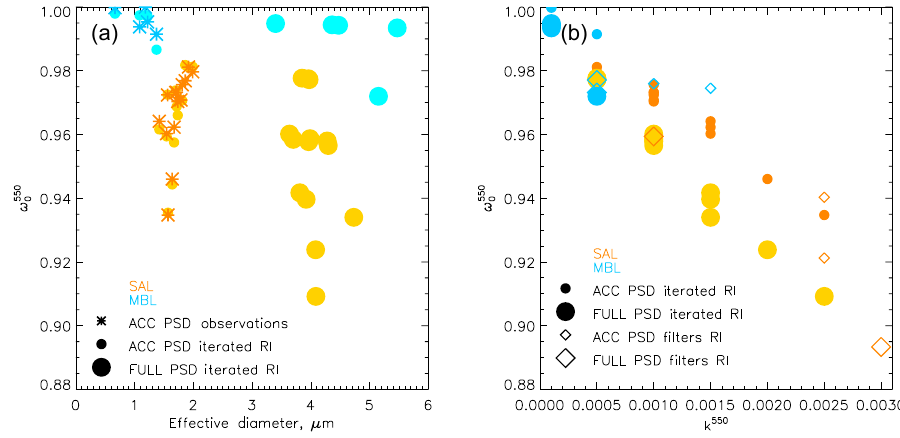
Figure 13. Contribution to single scattering albedo from particle size ( a SSA vs. d eff ) and from composition ( b SSA vs. k 550 ), separated by SLRs in the SAL (orange and yellow) and MBL (blue). Small data points represent the ACC PSD only; large data points represent the FULL PSD. Asterisks in (a) are direct observations behind inlets. Circles represent calculations using the RI derived from Mie iterations; diamonds represent calculations using RI derived from composition data from filter samples assuming internal mixing (four samples). For the FULL PSD with the iterated RI, the same accumulation mode RI is extended to the coarse mode. For the filter RI, a size-specific RI is used for the accumulation mode and the FULL PSD (as given in Table